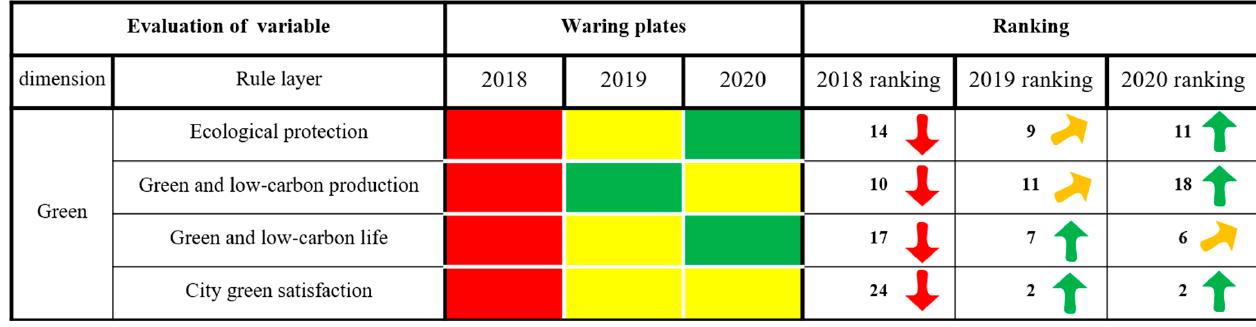
Figure 9. The results of the green city dimension of health examination and evaluation in Xining City.